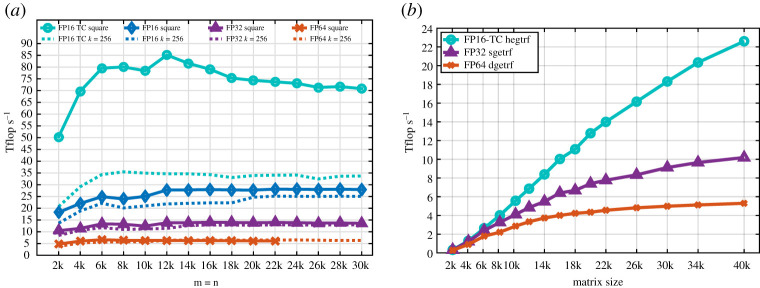
Performance of the LU factorization (the Xgetrf routine) and its main building block (the Xgemm routine) in FP64, FP32 and FP16-TC precisions on an NVIDIA V100 GPU. (a) Performance of Xgemm for square matrices and for the rank-k update used in the LU factorization (Xgetrf). (b) Performance of Xgetrf for different precisions. (Online version in colour.)